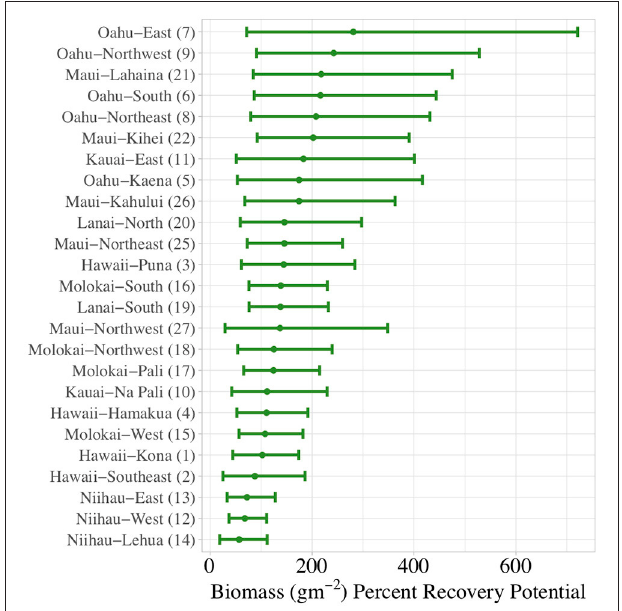
FIGURE 8 | Sector-level percent recovery potential (i.e., difference between model-predicted present-day and baseline biomass as a proportion of present-day biomass) for total reef fish in the main Hawaiian Islands. Means and 66% Bayesian Credible Intervals are shown.